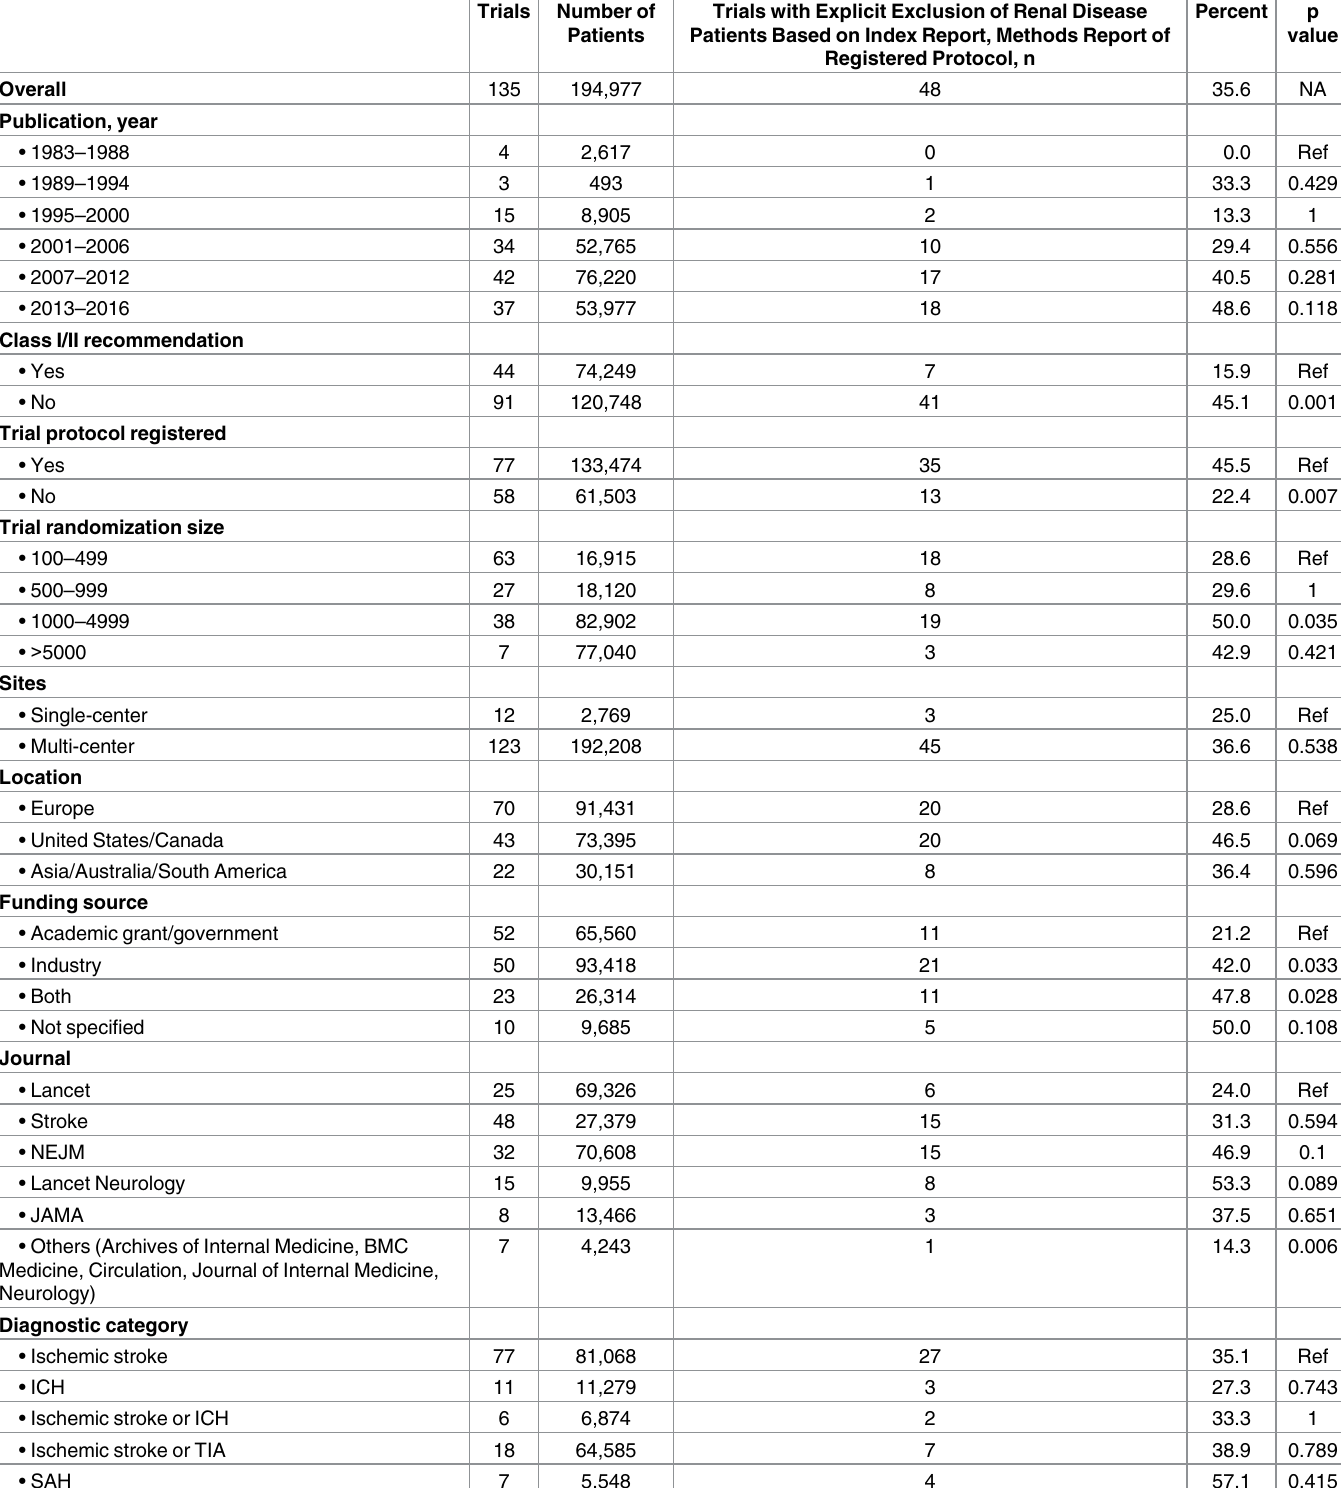
Table 1. Characteristics of cerebrovascular